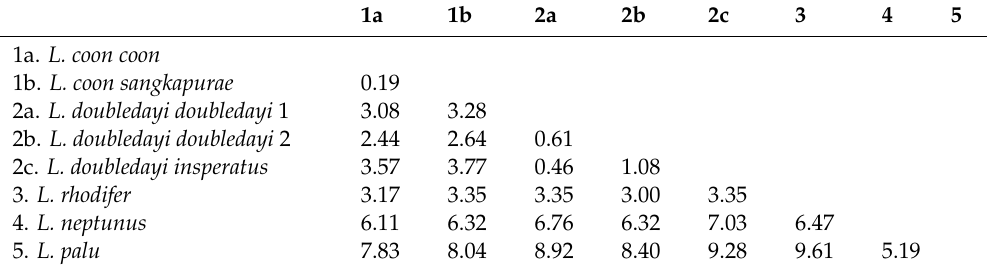
Table 3. The Kimura two-parameter distances (in percentages) between all taxa of genus Losaria (Moore, 1902), with species and subspecies identified as in the Bayesian phylogenetic tree, as shown in Figure 2.